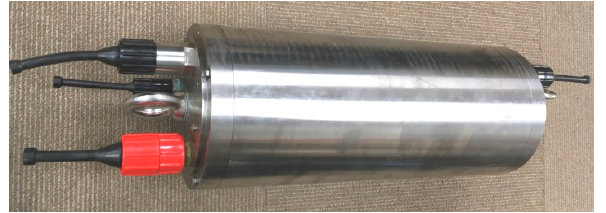
Figure 4. Data control module.